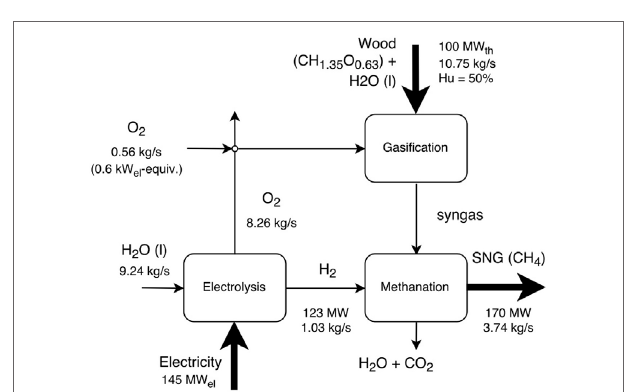
FigUre 2 | Integration pathway of the electrolysis in the directly heated gasification–methanation system. The mass and energy flows correspond to the system design in Gassner and Maréchal (2008), which maximizes the bio-SNG production.